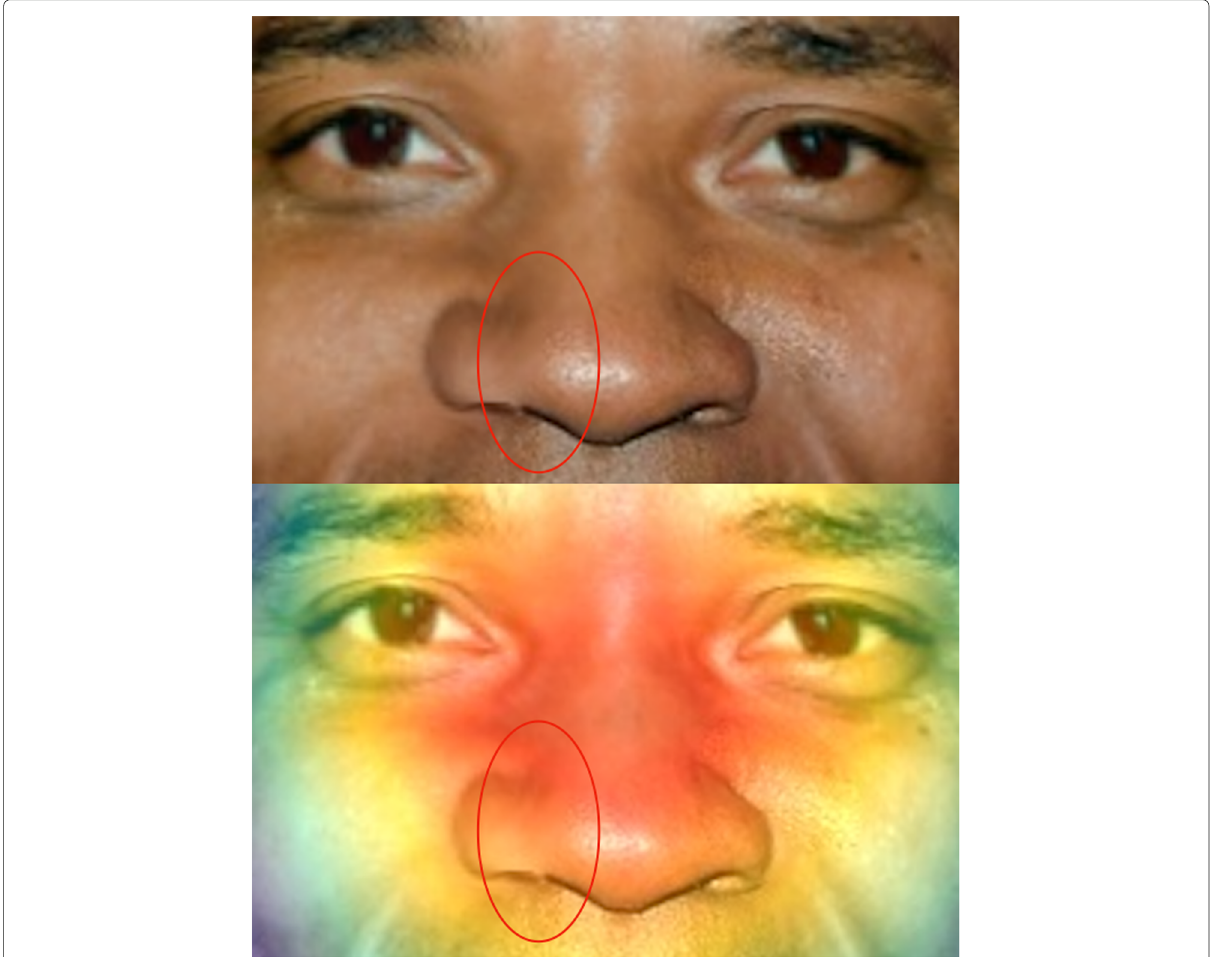
Fig. 4 An example of blurring difference contained on a nose from a swapped